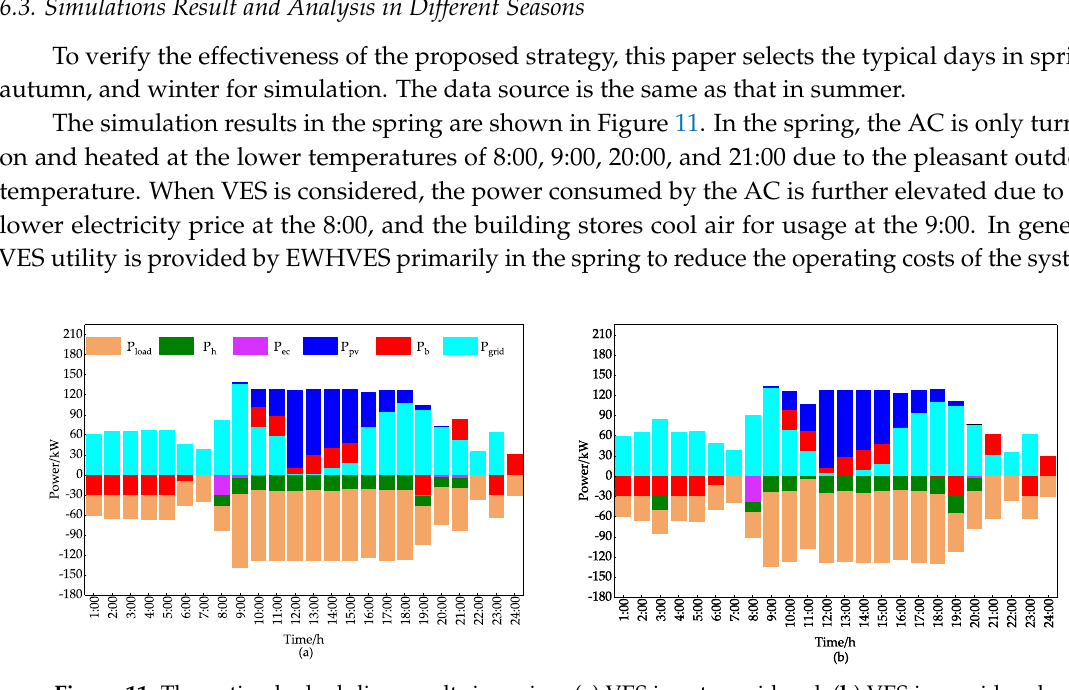
Figure 11. The optimal scheduling results in spring: ( a ) VES is not considered; ( b ) VES is considered.